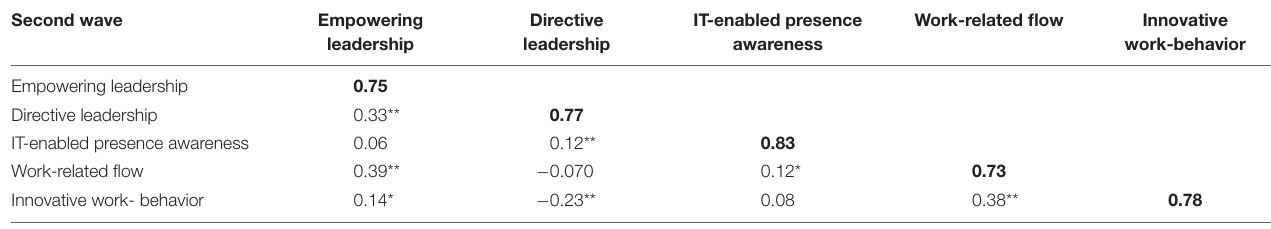
TABLE 5 | Correlations second wave and the square root of the Average Variance Extracted (in bold).